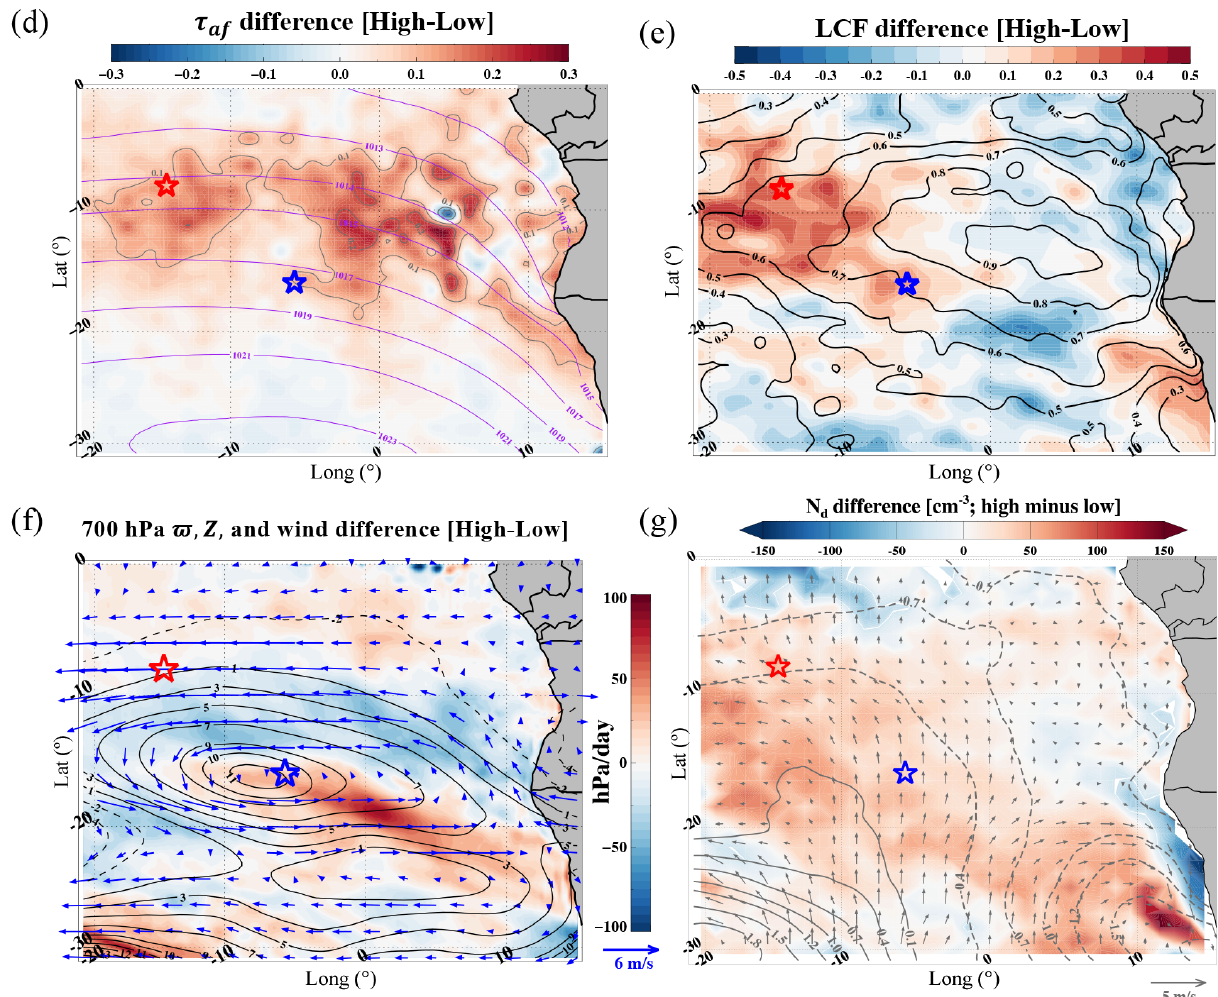
Figure 9. (a) As in Fig. 7a but for the high–low smoke composite difference in October 2016 only. (b) As in Fig. 6b and c but for October, with 3h rain frequencies derived from the tipping bucket. (c) As in Fig. 7b but for October. (d) MODIS daily τ af (color-filled contours), overlain with October mean sea level pressure (hectopascals; purple), (e) MODIS daily liquid cloud fraction (LCF; color-filled contours), overlain with October mean LCF (black), (f) ERA5 geopotential heights (meters; black contours), subsidence (color-filled contours), and horizontal winds (blue vectors) at 700hPa, and (g) daily MODIS–Meyer N d , overlain on differences in sea level pressure (hectopascals; gray contours) and 10m winds (gray vectors). Ascension and St. Helena island locations are indicated with red and blue stars, respectively, in panels (d–g) . Panels (b) – (f) are for October 2016 and 2017 combined, representing high–low smoke composite